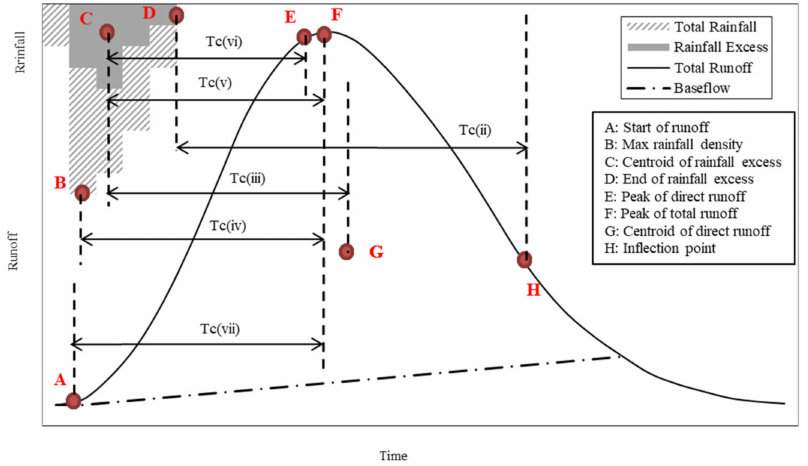
Figure 2. Schematic of rainfall hyetograph and runoff hydrograph to illustrate definitions of Tc. (Definitions ii, iii, iv, v, vi,